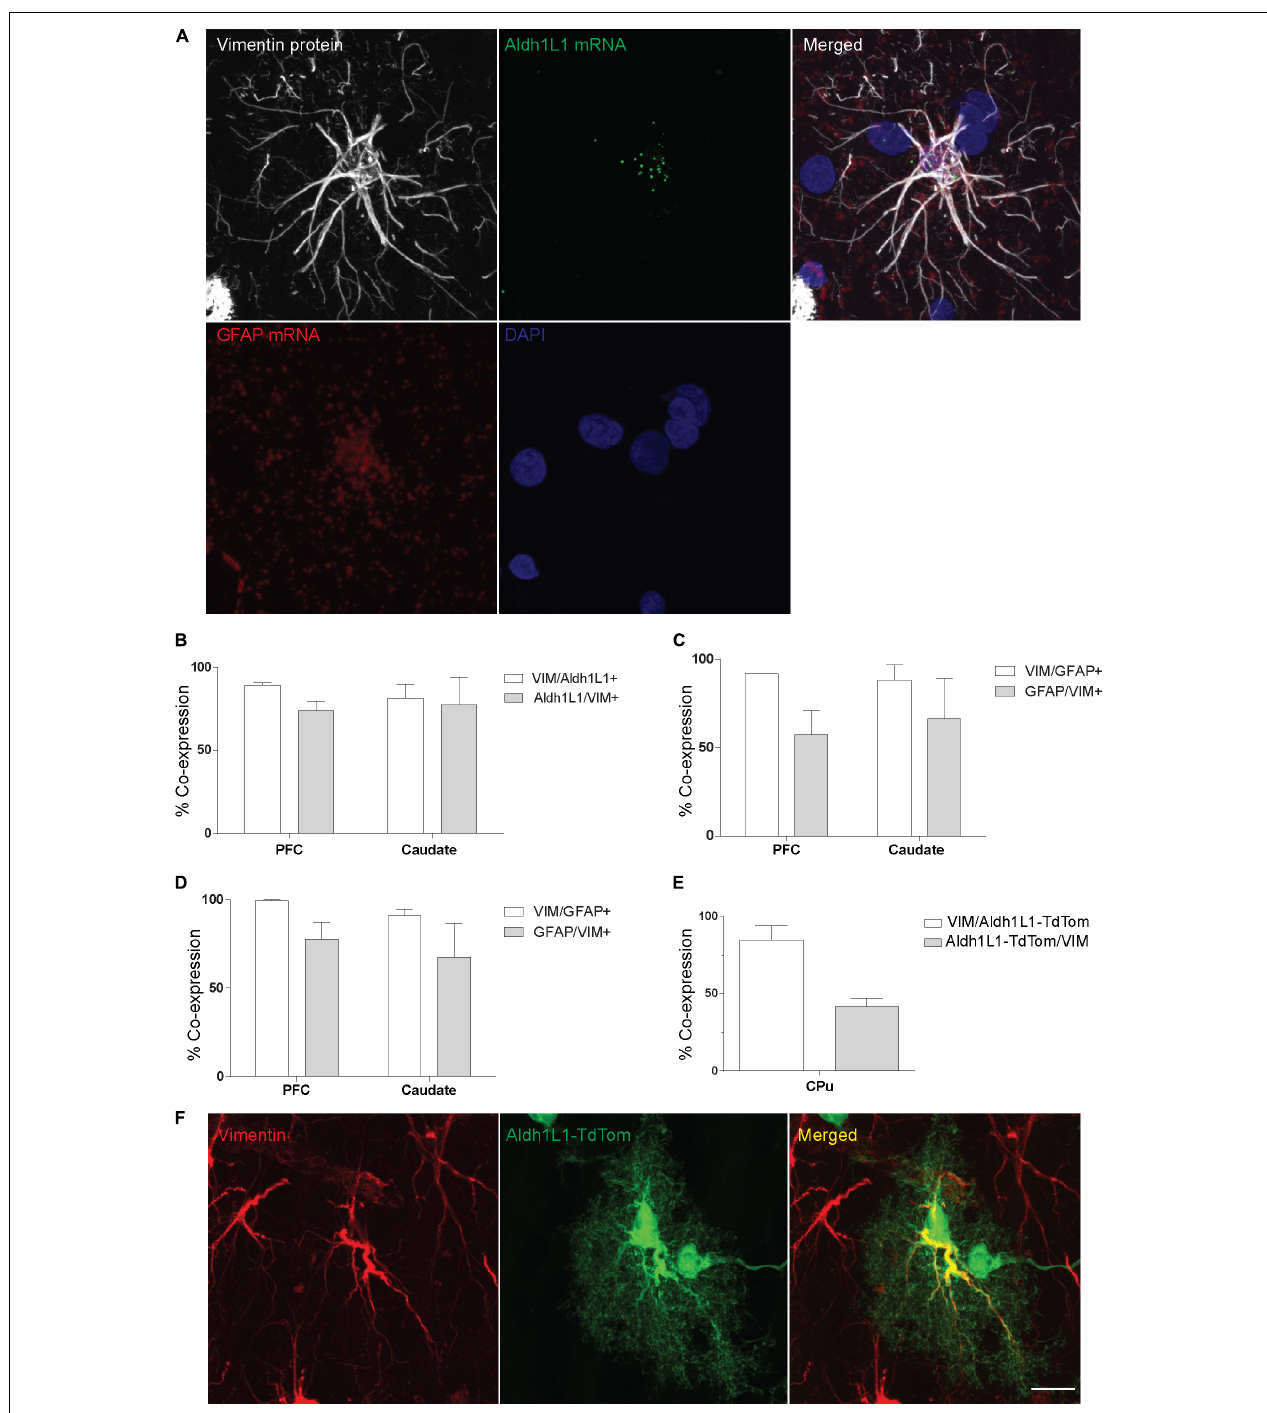
FIGURE 2 | VIM-IR cells express other astrocytic markers in adult human and mouse brain. (A) Representative example in the human prefrontal cortex of a VIM-IR astrocyte revealed using immunofluorescence (white), containing Aldh1L1 mRNA (green) and GFAP mRNA (red), revealed using fluorescent in situ hybridization (FISH), within the nucleus (DAPI-stained, blue). (B) By combining FISH with immunofluorescence, Aldh1L1 mRNA was observed in the majority of DAPI-stained nuclei of VIM-IR astrocytes in the PFC and the caudate nucleus ( n = 2). (C) By combining FISH with immunofluorescence, GFAP mRNA was observed in the majority of DAPI-stained nuclei of VIM-IR astrocytes in the PFC and the caudate nucleus ( n = 2). (D) Using coimmunofluorescence, the majority of astrocytes in the PFC and the caudate nucleus coexpressed VIM protein and GFAP protein ( n = 2). (E) In transgenic adult mice, the fluorescence of cre reporter proteins in astrocytes expressing Aldh1L1 was observed in many VIM-IR astrocytes in the caudate-putamen (CPu) ( n = 3). (F) VIM protein expression (red) was located within thick processes of transgenically Aldh1L1-labeled (green) astrocytes in the mouse CPu. Scale bars = 25 µ m.